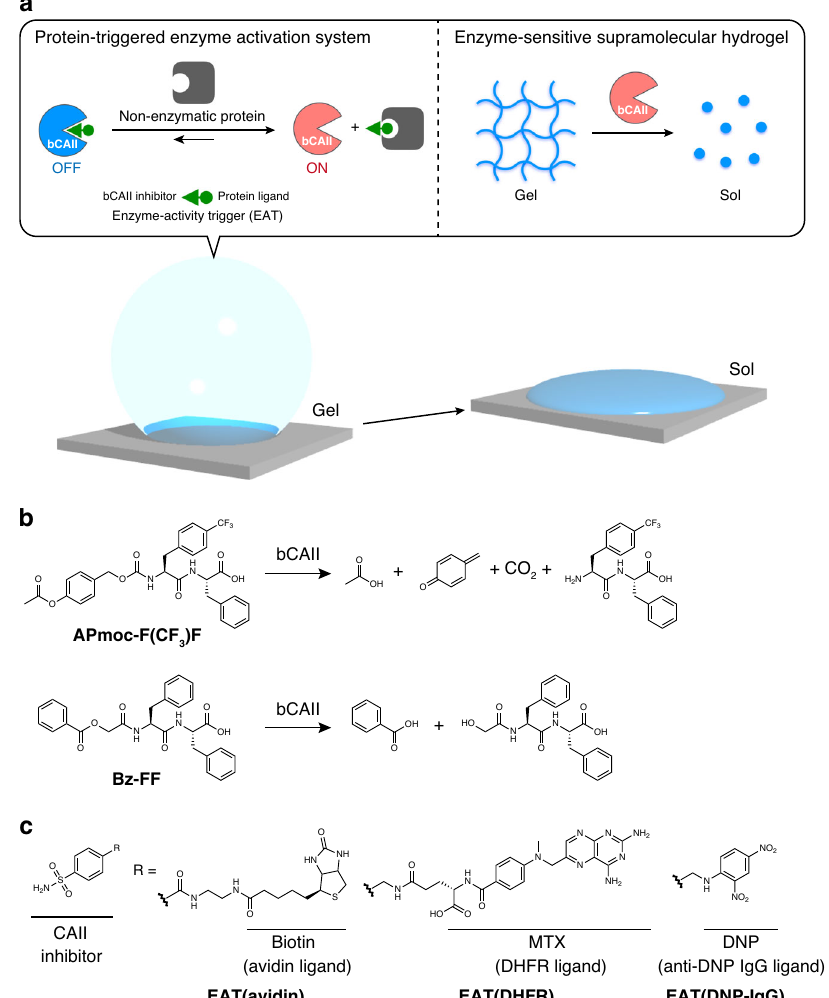
Fig. 1 Design of a non-enzymatic protein-responsive supramolecular hydrogel. a Schematic illustration of a non-enzymatic protein-responsive soft material consisting of an enzyme (bCAII)-sensitive supramolecular hydrogel and a protein-triggered bCAII activation system that converts an input signal (a non-enzymatic protein) into the enzymatic activity via enzyme-activity trigger (EAT). bCAII: bovine carbonic anhydrase II. b Chemical structures and plausible reaction schemes of APmoc-F(CF 3 )F and Bz-FF with bCAII. APmoc-F(CF 3 )F is a bCAII-responsive hydrogelator. APmoc-F(CF 3 )F showed the lowest critical gelation concentration (0.20 wt%) than other APmoc gelators we tested ( APmoc-FF , -F(F)F , -FF(F) , -F(F)F(F) , -FF(CF 3 ) , and -F(CF 3 )F (CF 3 ) ) (Supplementary Fig. 1). c Chemical structures of EAT(avidin) , EAT(DHFR) , and EAT(DNP-IgG) . DHFR: dihydrofolate reductase, DNP: dinitrophenyl, MTX: